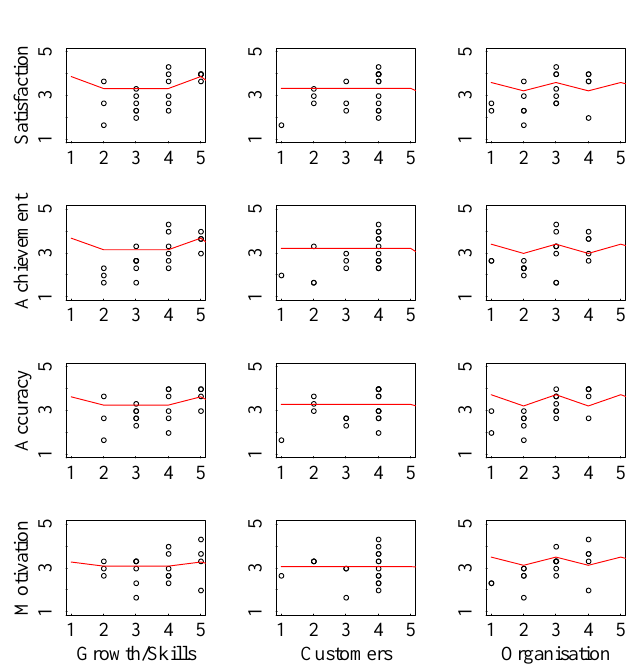
Figure 2. Correlation analysis of performance measures ( Y 1 , . . . , Y 4 ) on selected key training method variables ( X 4 , X 5 , X 6 ) for employees in the banking